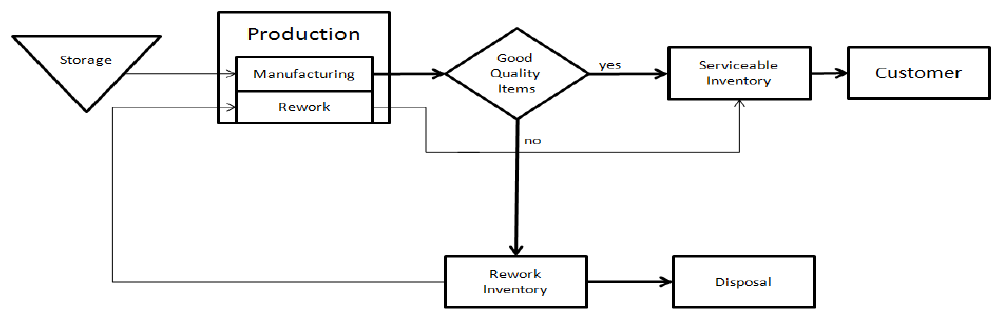
Figure 1. Illustration of the defective production process (see [49]).